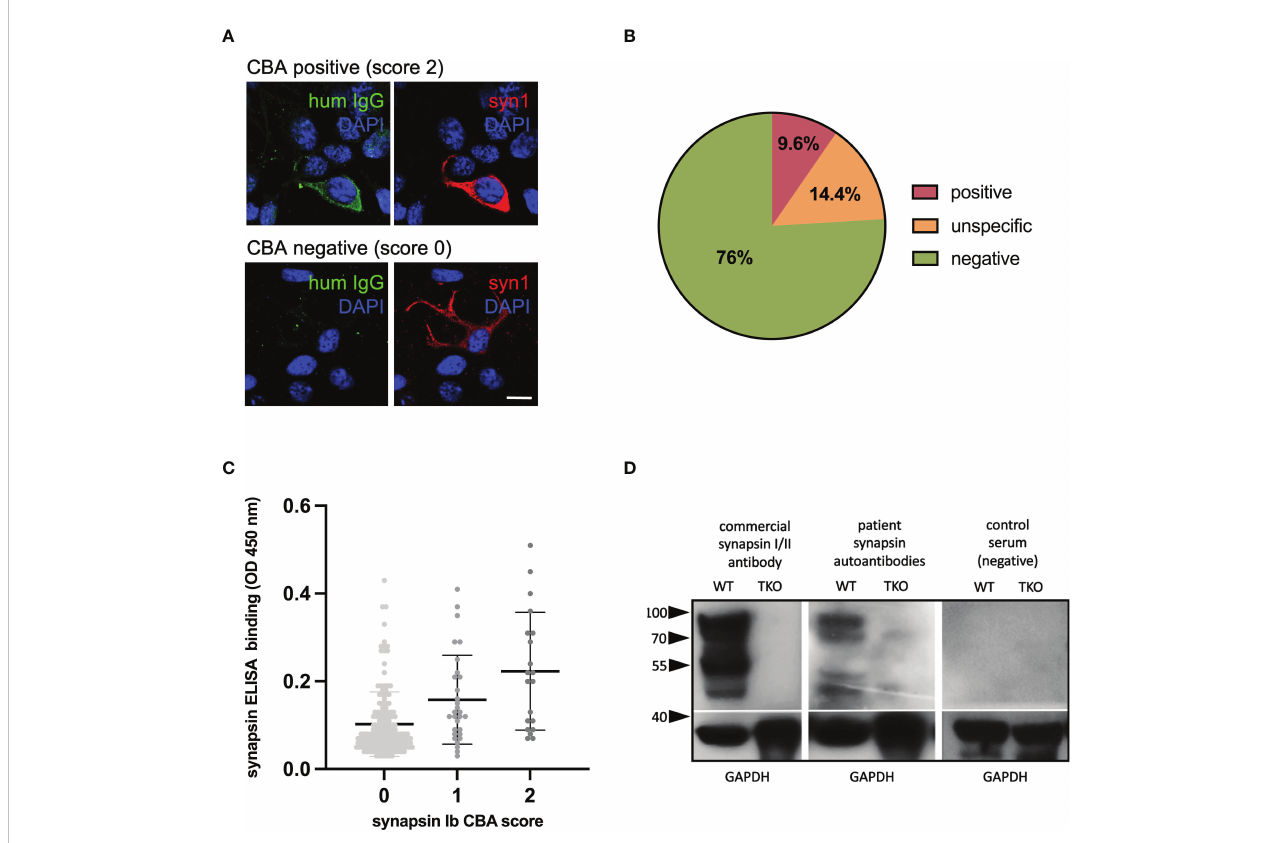
FIGURE 2 Detection of synapsin 1 (SYN1) autoantibodies. (A) Examples of immuno fl uorescence stainings, using human sera at a 1:300 dilution (green) with or without binding to HEK cells overexpressing human SYN1b are shown in the top row and bottom row. Using a commercial SYN1/2 antibody, protein expression is veri fi ed (red). DAPI is used to stain the nuclei (blue). Scale bar: 20 µm. (B) In 9.6% of mothers SYN1 autoantibodies were detected using a CBA. (C) CBA and in-house ELISA correlated weakly, with higher mean serum IgG levels in the CBA-positive group. (D) Representative immunoblots of wild type (WT) and Syn1/2/3 triple KO (TKO) mice cortex homogenates with a commercial synapsin 1/2 antibody as positive control, and with sera (1:200 dilution) from a CBA-positive mother and a CBA-negative control. Major bands at 80-90 kDa corresponding to the molecular weight of synapsin 1a/1b and additional bands at 50-55 kDa that could represent the synapsin 2b isoform or breakdown products of synapsin 1 were detected in wild type but not in TKO mouse tissue by both the commercial antibody and the serum of the CBA-positive mother. Detection of GAPDH served as loading control. HEK human embryonic kidney; CBA, cell-based assay; ELISA, enzyme-linked immunosorbent assay, WB, western